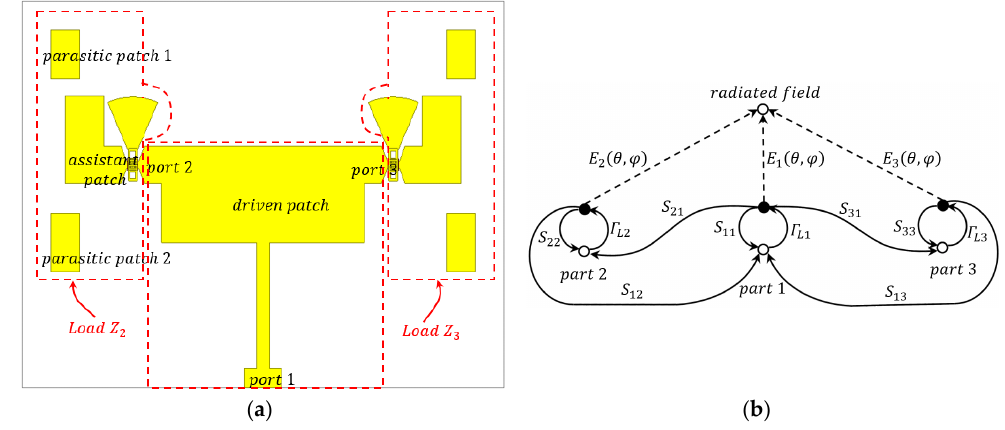
Figure 3. Divided parts of the antenna and its signal flow diagram. ( a ) Divided parts of the antenna. ( b ) Equivalent signal flow diagram of the proposed pattern reconfigurable antenna.